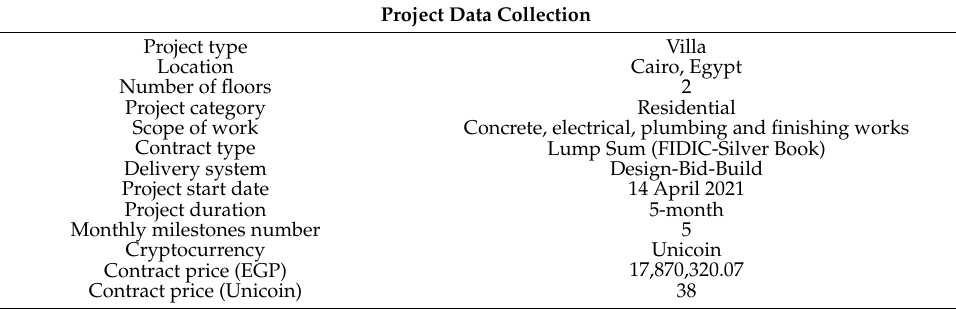
Table A1. The case study data